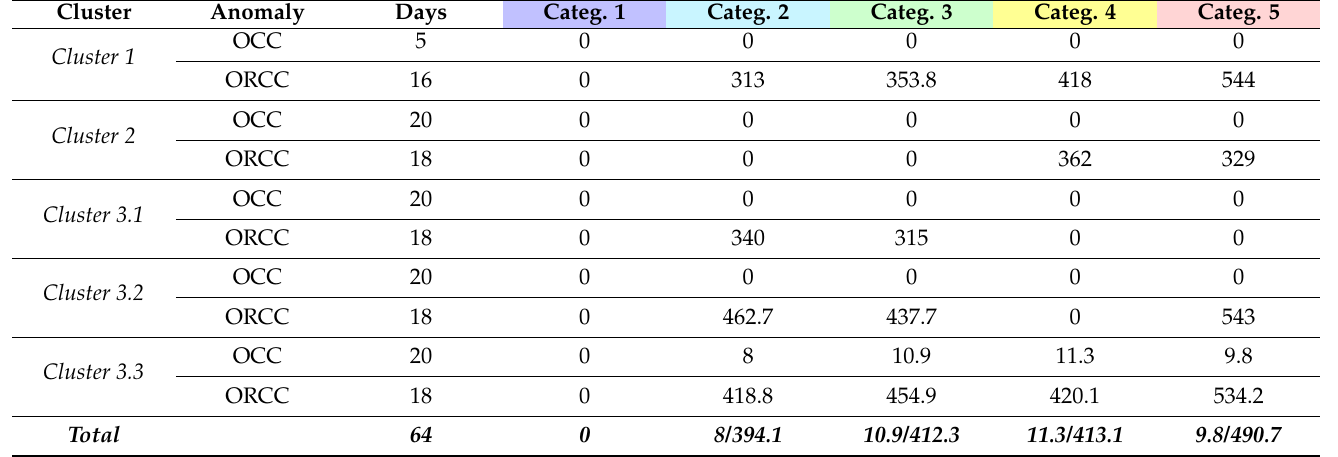
Table 9. Average stop points and minutes per day for OCC and ORCC anomalies. Each EE Category is associated with a color as depicted in Figure